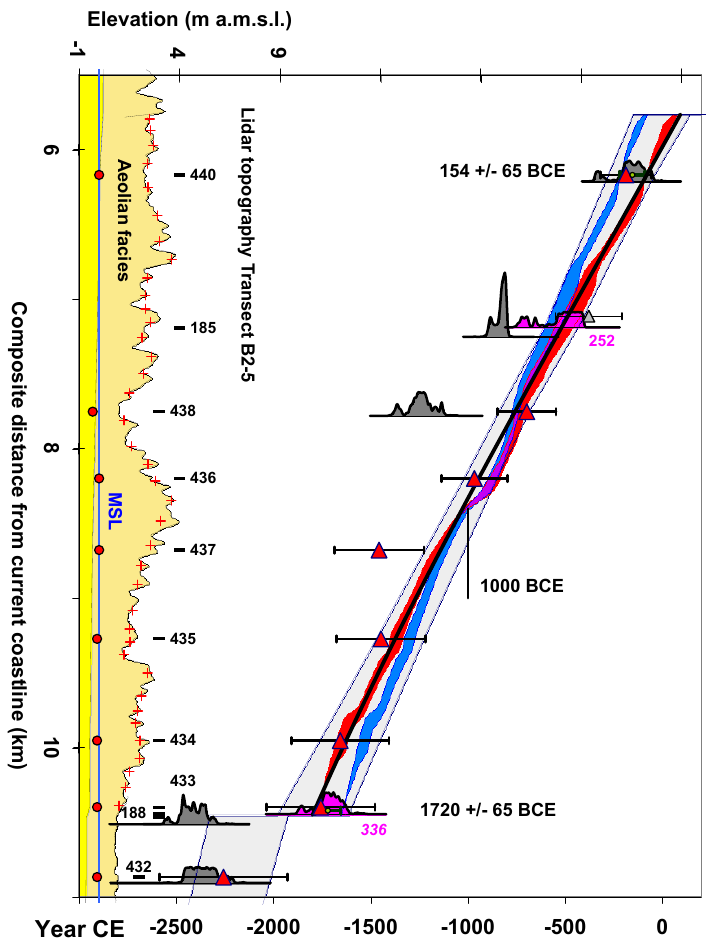
Figure B2. Age–distance scenarios for Transect B2, assuming a constant aeolian accretion rate in a shore-normal direction. The combined calibrated ages for OSL and AMS samples 440 and 433/336 (154 ± 65 and 1720 ± 65 BCE), calculated with Oxcal 4.2 (Bronk Ramsey, 2009) using the IntCal13 calibration curve (Reimer et al., 2013), are used as model boundaries. Indicated are five long-range (red) and five short-range (blue) scenarios for Transects B2-1 to B2-5. The calibrated 1 σ age range for a P_sequence model solely based on OSL ages (excluding sample 437) is indicated in